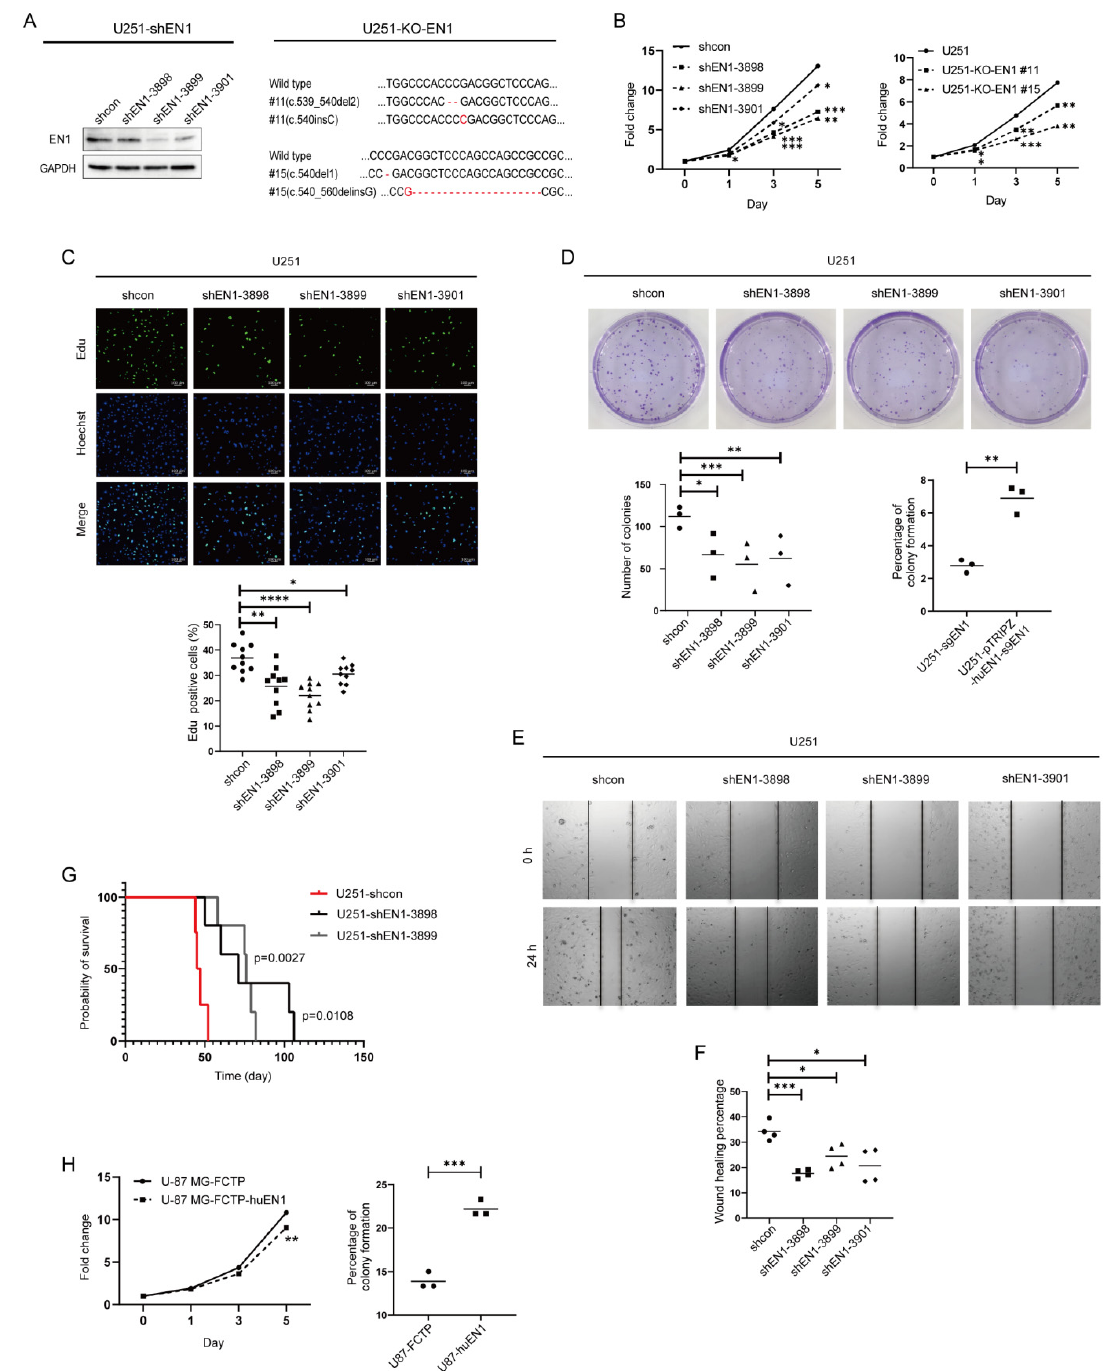
Figure 2. EN1 knockdown restrains the proliferation and migration of glioma cells. ( A ) Assessment of knockdown efficiency for EN1 with immunoblotting, and confirmation of EN1 knockout in U251 cells with immunoblotting and genome sequencing. Cell proliferation was assessed using CellTiter- Glo assays ( B ), 5-ethynyl-2 (cid:48) -deoxyuridine (Edu) assays ( C ), and colony formation assays ( D ) ( • for shcon, (cid:4) for shEN1-3898, (cid:78) for shEN1-3899, (cid:7) for shEN1-3901). ( E ) Cell migration was assessed with a wound-healing assay. ( F ) Quantification of wound-healing assay. ( G ) Survival curves for mice bearing xenograft tumors derived from shRNA-EN1 cells or scramble control cells. ( H ) Cell proliferation was assessed by CellTiter-Glo and colony formation assays in U-87 MG cells after EN1 overexpression. Scale bar: 100 µ m. Data are presented as the mean ± SEM from three independent experiments. * p < 0.05, ** p < 0.01, *** p < 0.001, **** p < 0.0001 according to Student’s t